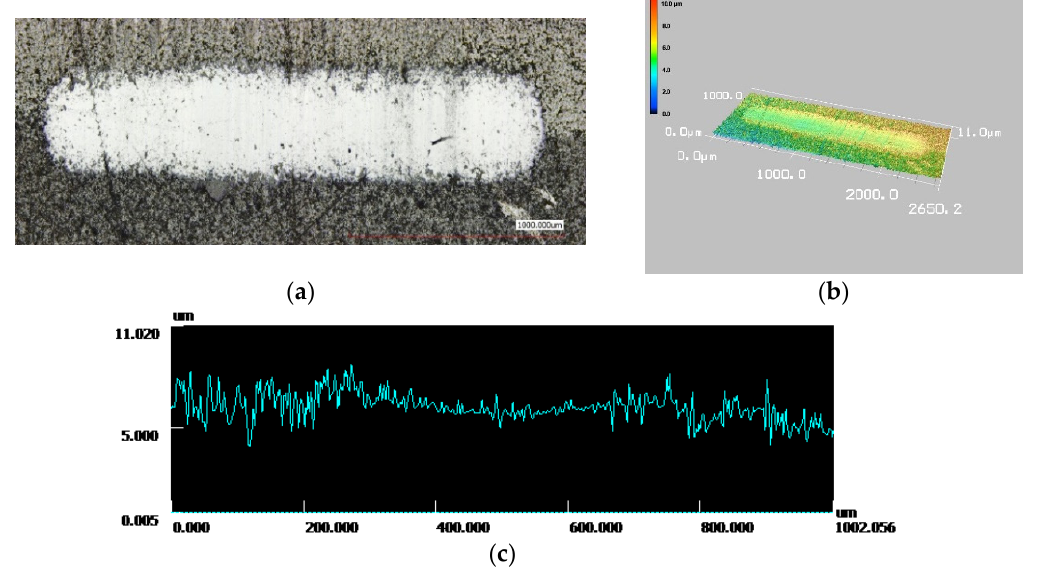
Figure 7. ( a ) Sample groove after wear test; ( b ) 3D-view; ( c ) profile perpendicular to longer axis: W– B coating. Table 5. Volume of loss material after wear tests.